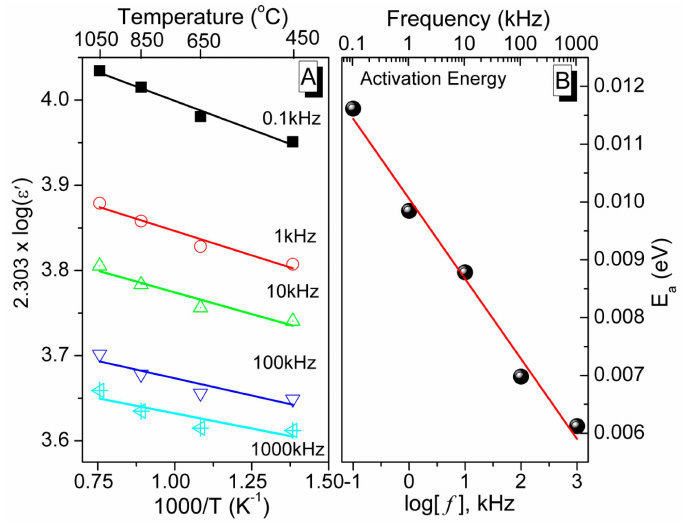
Figure 12. ( A ) Arrhenius plots of sintering temperature dependence dielectric constants of the sintered pellets and ( B ) activation energy (E a ) of the sample at frequencies 0.1, 1, 10, 100, and 100 kHz. Note: the symbols represent the experimental data and lines represent the linear fitted